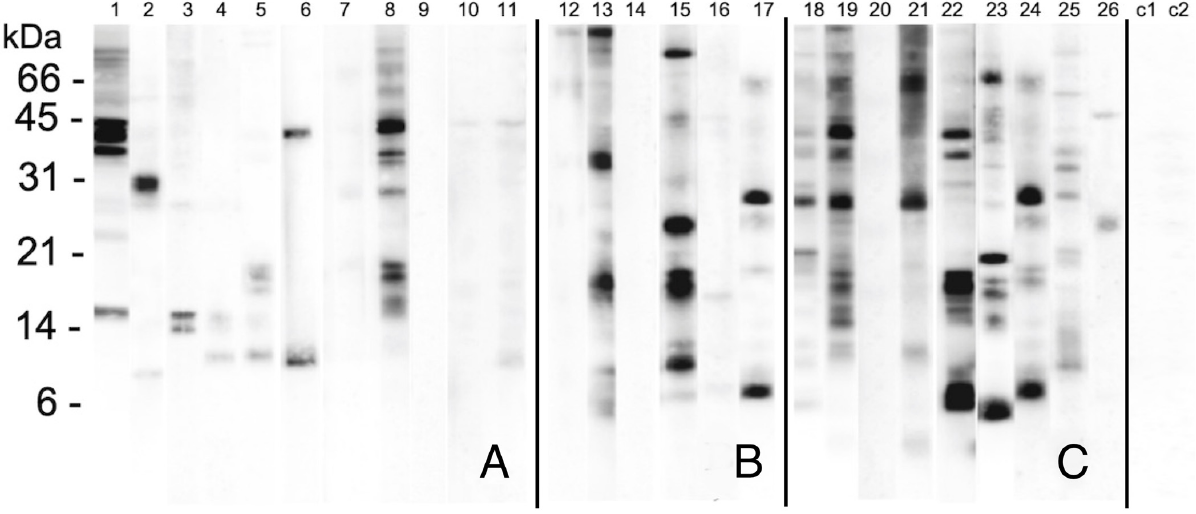
Figure 1. WSSP resolved by SDS-PAGE and probed with the single sera of the bakers with work- related symptoms: rhinitis only (panel ( A ), lanes 1–11), asthma only (panel ( B ), lanes 12–17), asthma and rhinitis (panel ( C ), lanes 18–26) and controls (lane C1 and C2).